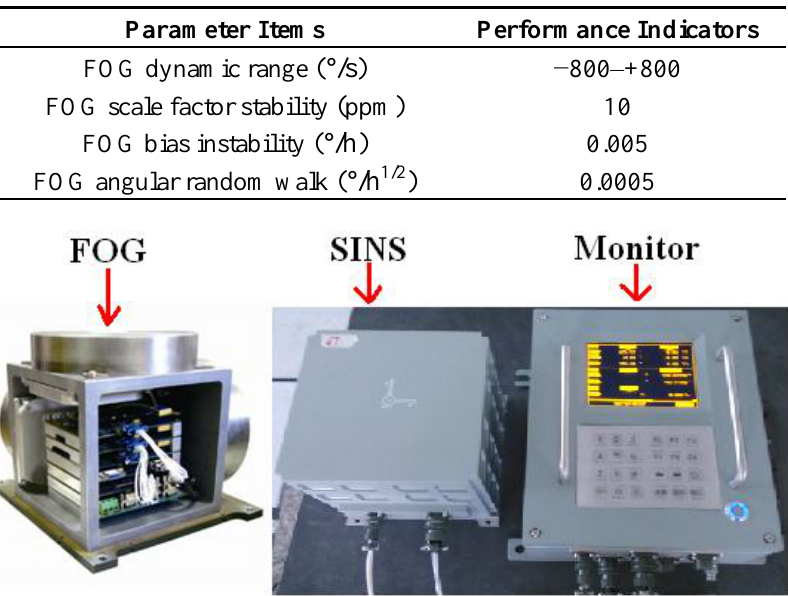
Table 4. FOG performance indicators.